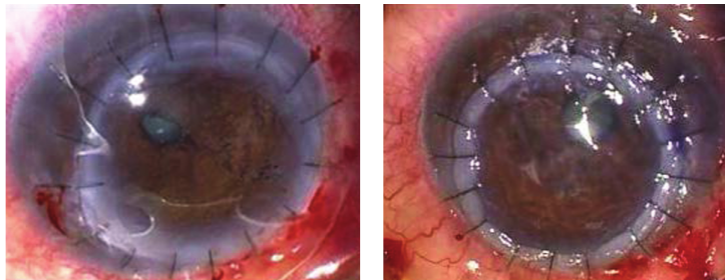
Figure 2: Bilateral iris reconstruction and inferonasal tectonic keratoplasties, June